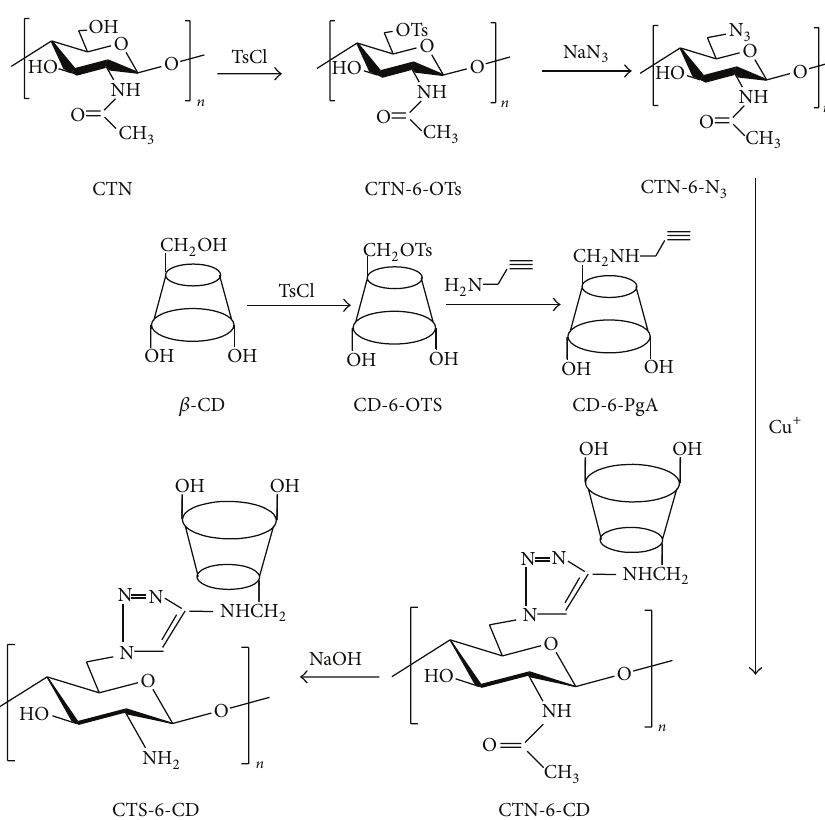
Figure 1: The main reaction route for preparation of C 6 -immobilized 𝛽 -cyclodextrin of chitosan via click reaction of chitin derivative.